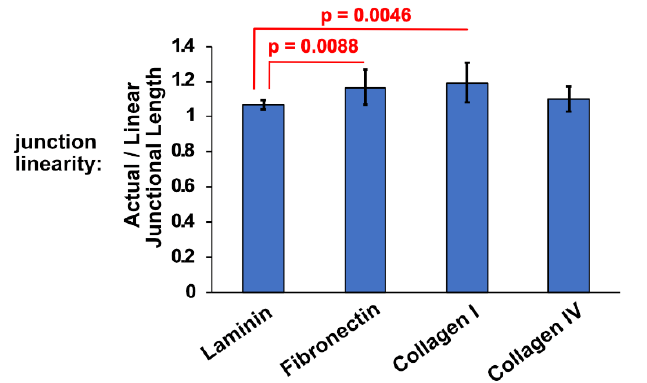
Figure 7. Average actual (wriggled)/linear junctional length (measured in µm) ratio of cells plated on different ECM substrates (for representative images, see Figure 1A). The data were analyzed using a student t -test, where p < 0.05 and n = 27.